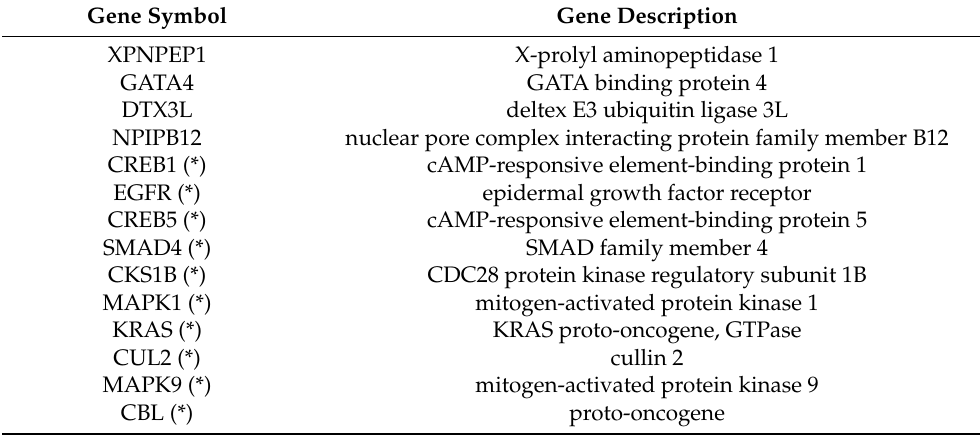
Table 6. The genes selected by the genetic algorithm, sorted by frequency of occurrence in the final 72 individuals with the best accuracy and fitness. The genes known to be correlated to cancer are marked with